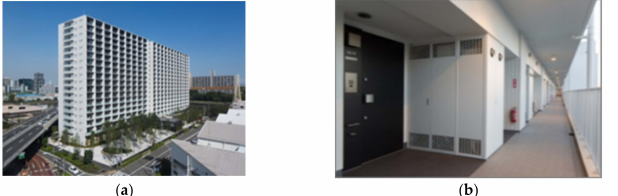
Figure 1. ( a ) Investigated condominium; ( b ) installed polymer electrolyte fuel cell cogeneration system (CGS).